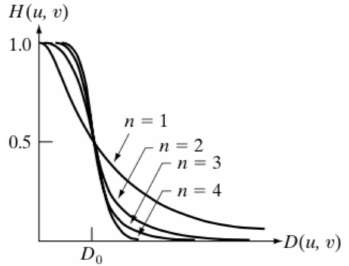
Figure 7. Traditional Butterworth filter